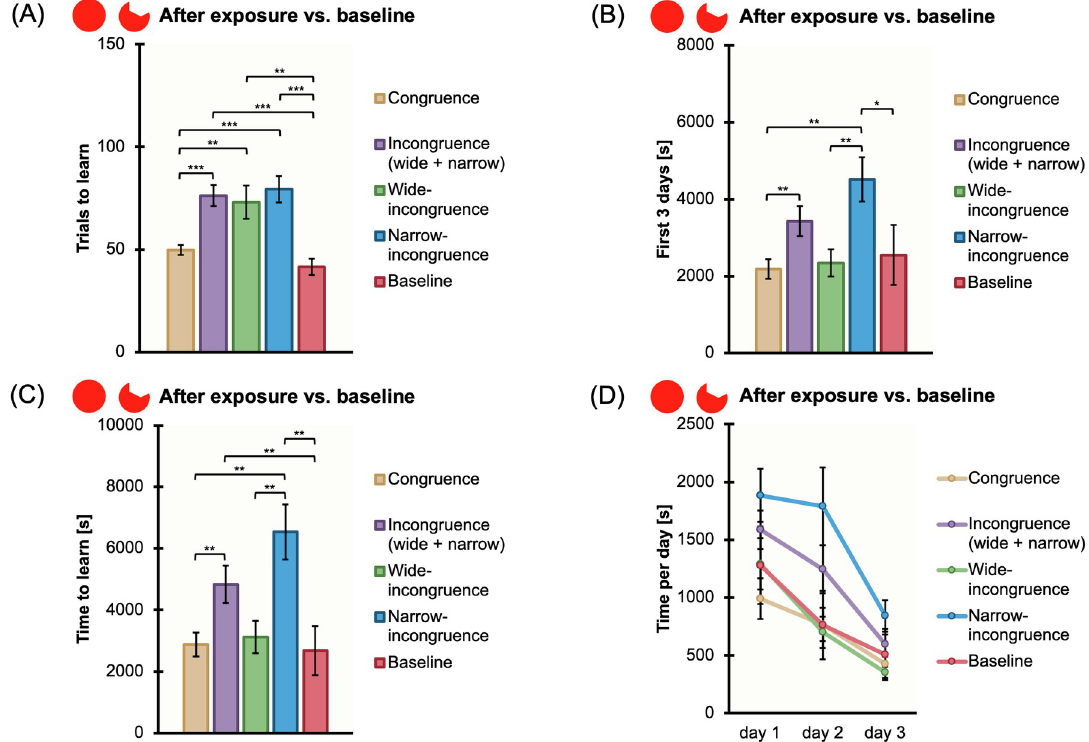
Fig 6. Comparison among conditions and experiments. The bar charts show all the comparisons among the congruence and incongruence conditions of Experiment 1 (full red disk vs. amputated red disk discrimination learning after exposure), and the comparison between Experiment 1 and the baseline of Experiment 3 (full red disk vs. amputated red disk discrimination learning without exposure), for the four variables measured: The mean number of trials to learn the discrimination, “Trials to learn” (A); the total amount of time spent, in seconds, during the experimental trials to exit the arena, considering the first 3 days of training, “First 3 days” (B); the total amount of time spent, in seconds, during the experimental trials to exit the arena, considering all the trials needed to meet the learning criterion, “Time to learn” (C); the time spent, in seconds, during the experimental trials to exit the arena, considering the first 3 days of training separately, “Time per day” (D). Mean ± SEM are shown; asterisks indicate statistically significant differences ( p �